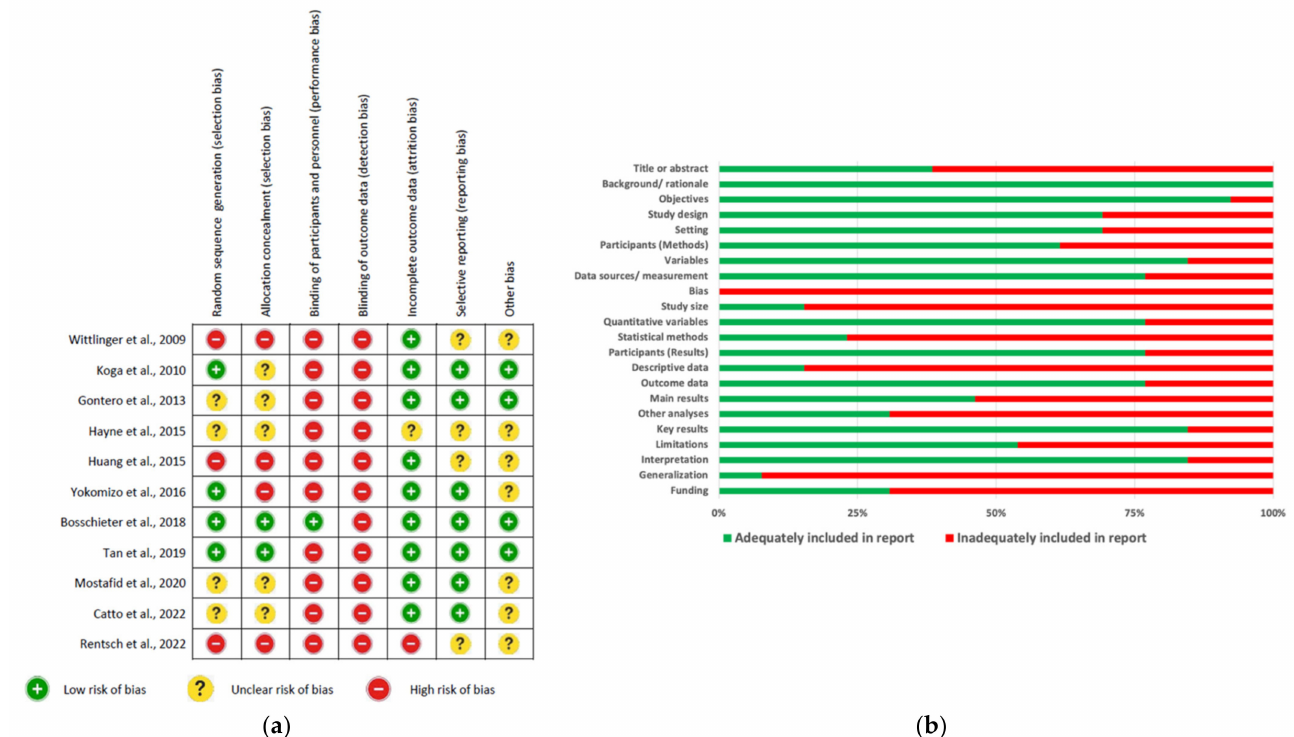
Figure 3. Summary of risk of bias results evaluated by using the STROBE Statement checklist for interventional studies: ( a ) The risk of bias levels of items rated in every included study; ( b ) the percentage of each risk of bias level of the items